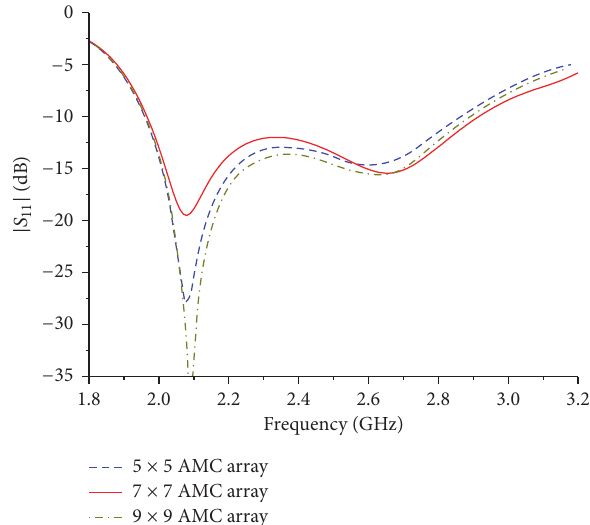
Figure 7: Simulated |𝑆 11 | of the proposed dual-polarized antenna with different 𝐻 .